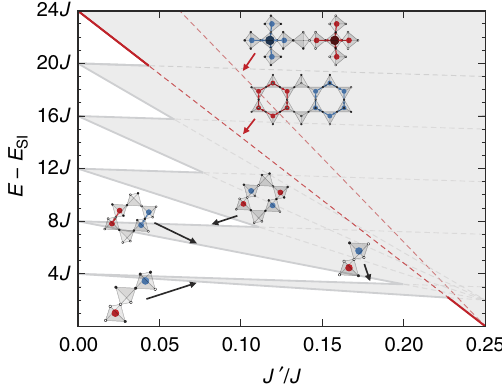
Figure 2 | Collapse of excitations in extended spin ice. We sketch the structure of the excited states of the model of equation (3) along the J 2 ¼ J 3a (cid:2) J 0 line. When J 0 is non-zero, the highly degenerate bands of single- and double-charge states are split due to the nearest-neighbour attraction embodied in the second term in equation (5). For the low lying bands, we illustrate the charge arrangements that are favoured and those that are disfavoured by J 0 . Near the spin slush at J 0 / J B 1/4, an infinite set of excited states collapse to zero energy. We have illustrated two of the simplest examples, built from twelve charges, with energy shown by red lines. NATURE COMMUNICATIONS|7:12234|DOI: